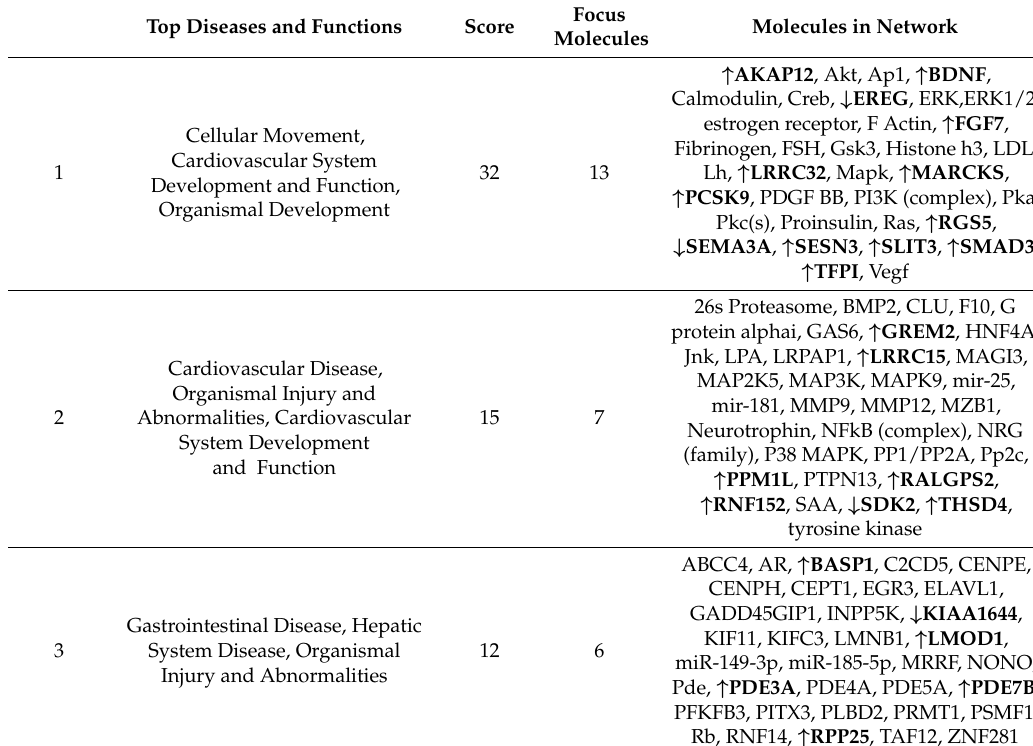
Table 7. Networks associated with 26 candidate genes differentially expressed in OA knee